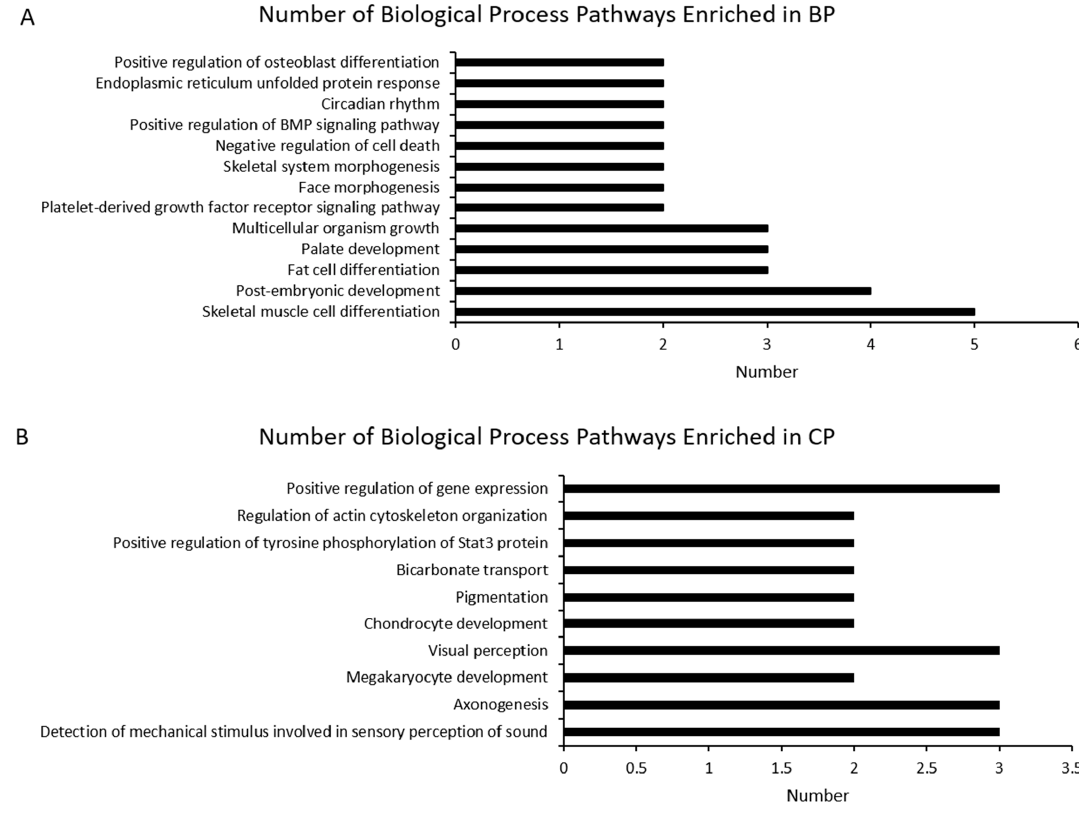
Figure 4. Gene ontology (GO) analysis of differentially expressed genes highly expressed in BP ( A ) and CP ( B ). The identified differentially expressed genes were classified into biological processes. The numbers of genes in the GO term is shown above (BP vs. CP; CP: cross-bred commercial pigs, BP: Large Black pigs).